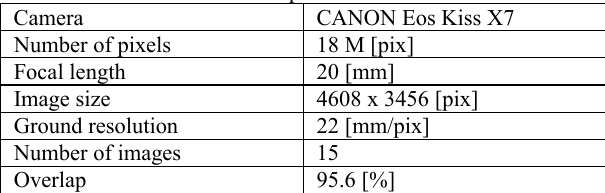
Table 3. Camera specifications of UAV